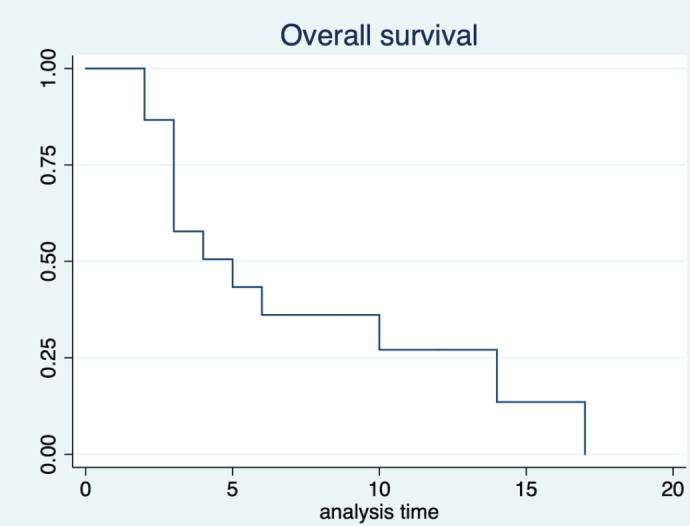
Overall survival.